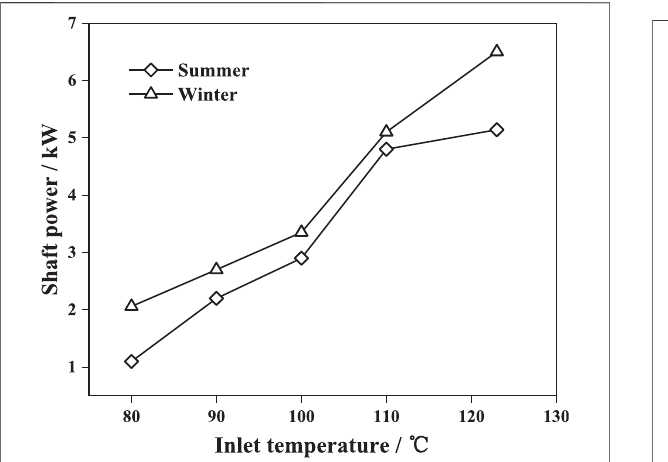
FIGURE 7 | The variation of shaft ef fi ciency with inlet temperature in summer and